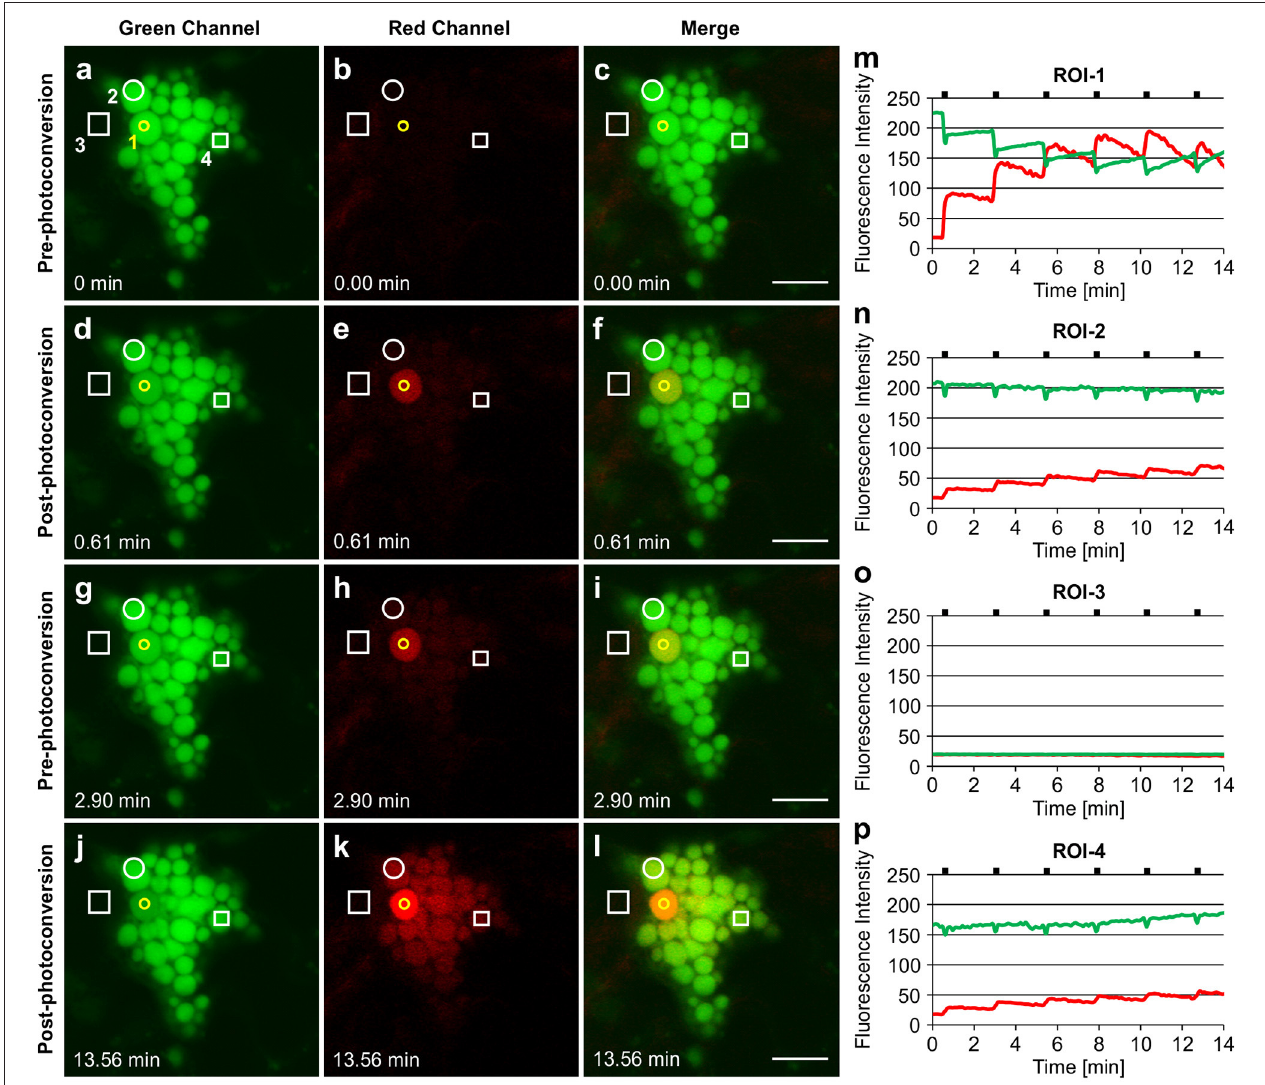
FIGURE 6 | Trafficking of proteins between ELP-induced protein bodies. (A–C). GFP-ELP induced PBs form clusters and can only be visualized in the green channel before photoconversion. The yellow circle represents the region of irradiation (ROI-1). Regions of interest (ROI 2-4) are shown in white. (D–F) . Photoconversion of the whole PB upon irradiation of a specific region within a PB. (G–I) . Spread of the photoconverted red signal from ROI-1 into the neighboring (ROI-2) and distant (ROI-4) PBs within 2.30 min. ( J–L) . After multiple irradiations (with 2.30 min time intervals) of ROI-1, sufficient red fluorescence is produced that shows the trafficking of the photoconverted protein from ROI-1 to other PBs. (M–P) . Changes in fluorescence intensity of the green and red signal in ROI-1 (M) , ROI-2 (N) , ROI-3 (O) , and ROI-4 (P) . Notches indicate the time of irradiation. All images were acquired at 4-dpi in sequential mode. Bar, 10 µ m.